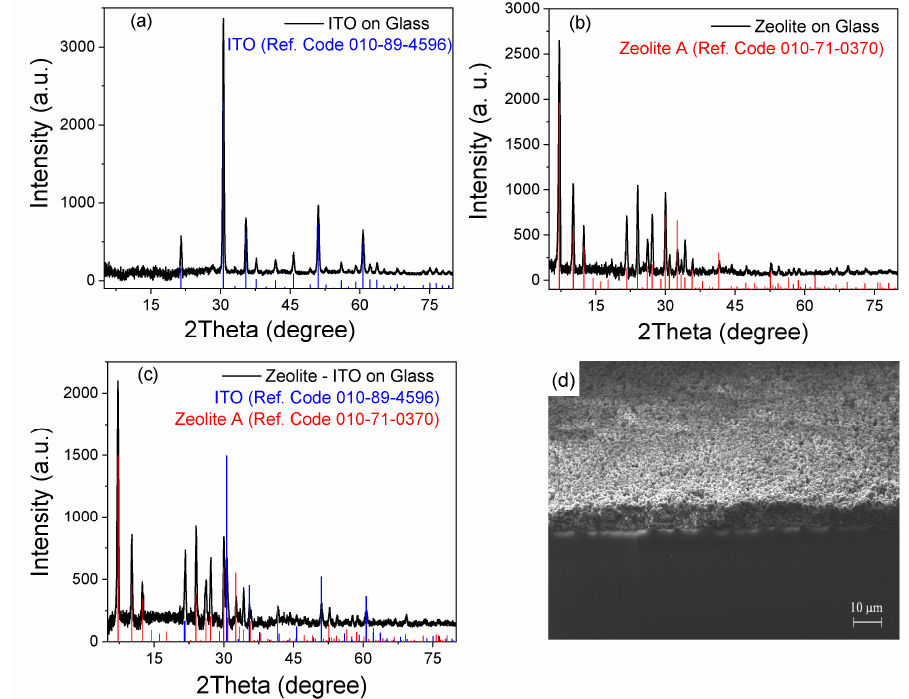
Figure 2. XRD patterns of ( a ) the ITO / glass, ( b ) zeolite / glass, and ( c ) zeolite / ITO / glass samples along with ( d ) an SEM cross-section of the zeolite / glass.